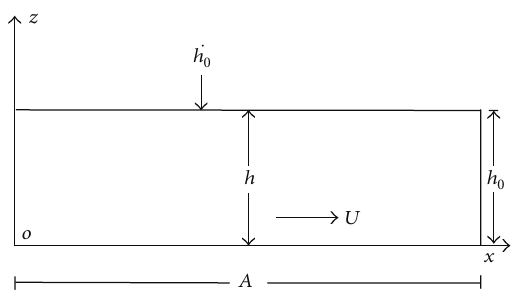
Figure 1: Configuration of the bearing